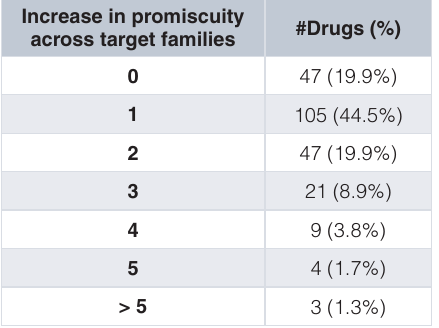
Table 3. Promiscuity increase across different target